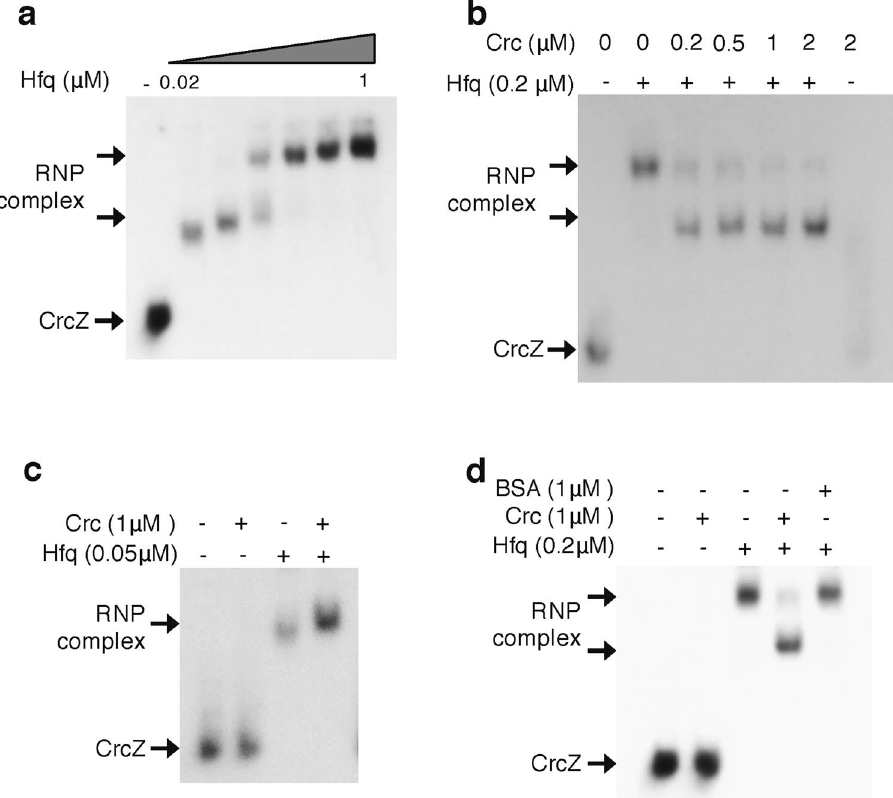
Figure 4. Hfq-Crc proteins form a stable ribonucleoprotein complex with CrcZ. Ribonucleoprotein complexes formed in the presence of the sRNA CrcZ and increasing concentrations of Hfq (0, 0.02, 0.05, 0.1, 0.2, 0.5 and 1 µ M) ( a ) or in the presence of both Crc and Hfq ( b and c ). In ( d ) Crc was substituted by 1 µ M of bovine serum albumin (BSA). Crc and Hfq were added at the indicated concentrations (expressed as monomers and hexamers respectively). RNA and protein-RNA complexes were resolved in a non-denaturing polyacrylamide gel. The position of free RNA, and of the ribonucleoprotein (RNP) complexes detected, is